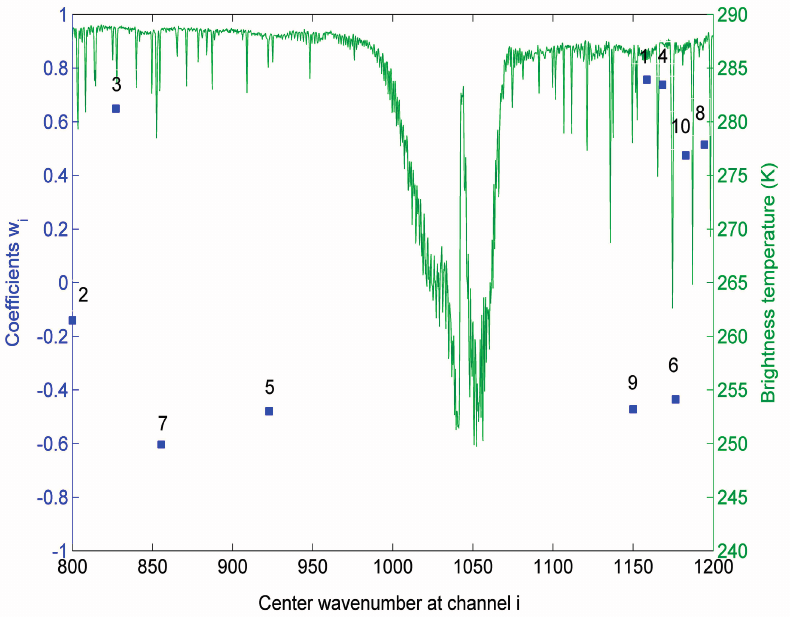
Figure 4. The centre wavenumbers at channel i ( i = [1,p]) and coefficients w i ( i = [0,p]) superimposed on a typical IASI spectrum. (w 0 = 2.486; the No. above each blue square indicate the order of each channel in the determination